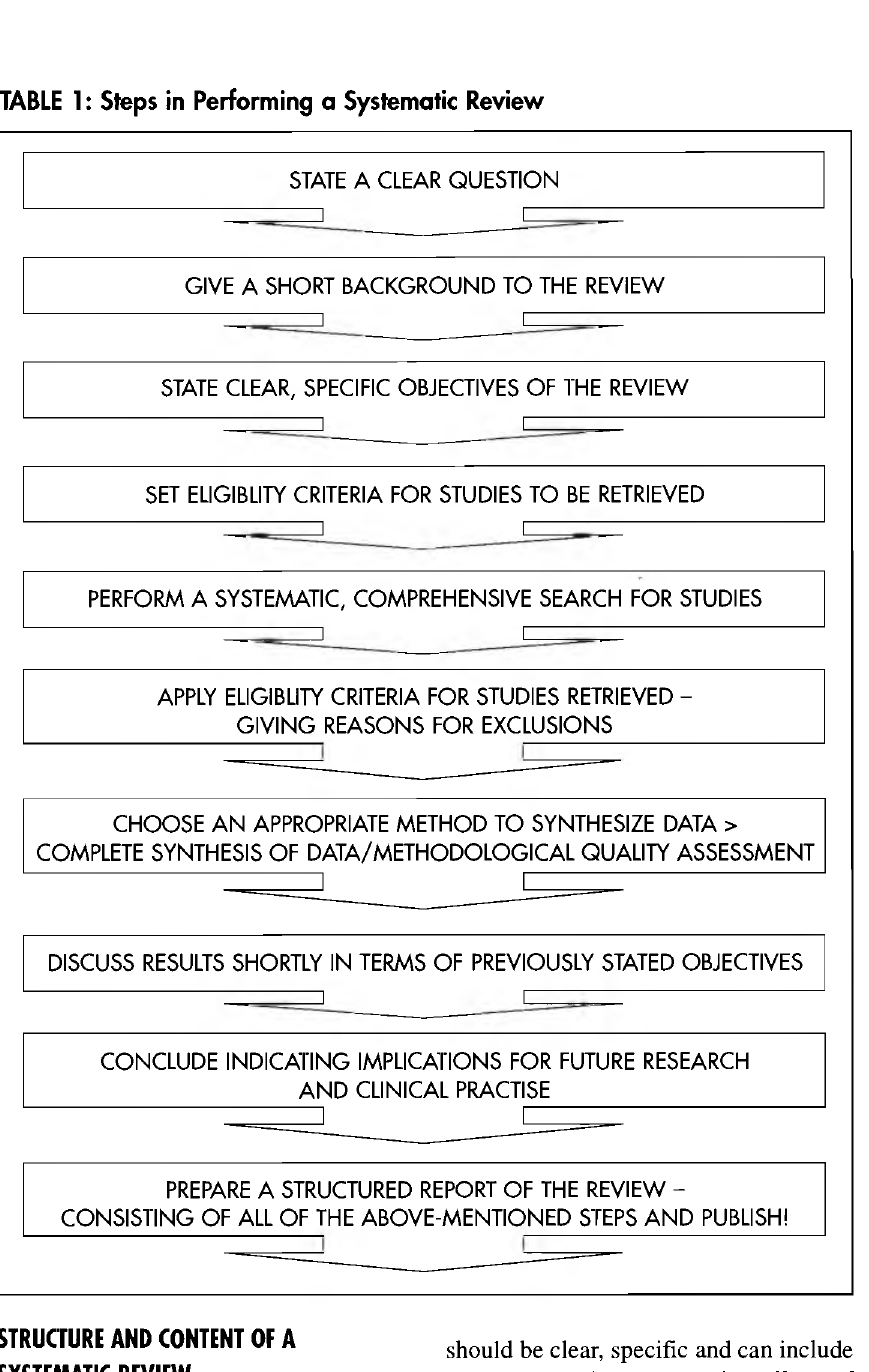
TABLE 1: Steps in Performing a Systematic